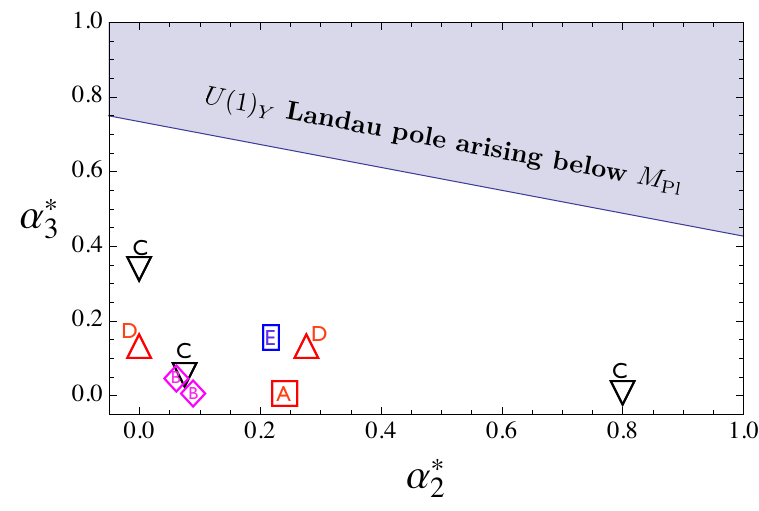
Figure 15 . Shown is a conservative estimate for the exclusion area (gray) of (cid:12)xed point values for the gauge couplings ( (cid:11) 2 ; (cid:11) 3 ) to ensure the absence of a Landau pole for the U(1) Y hypercharge below Planckian energies. Equally shown are the partially and fully interacting (cid:12)xed point values for the benchmark models A; B; C; D and E given in table 7, for comparison. All benchmark models are